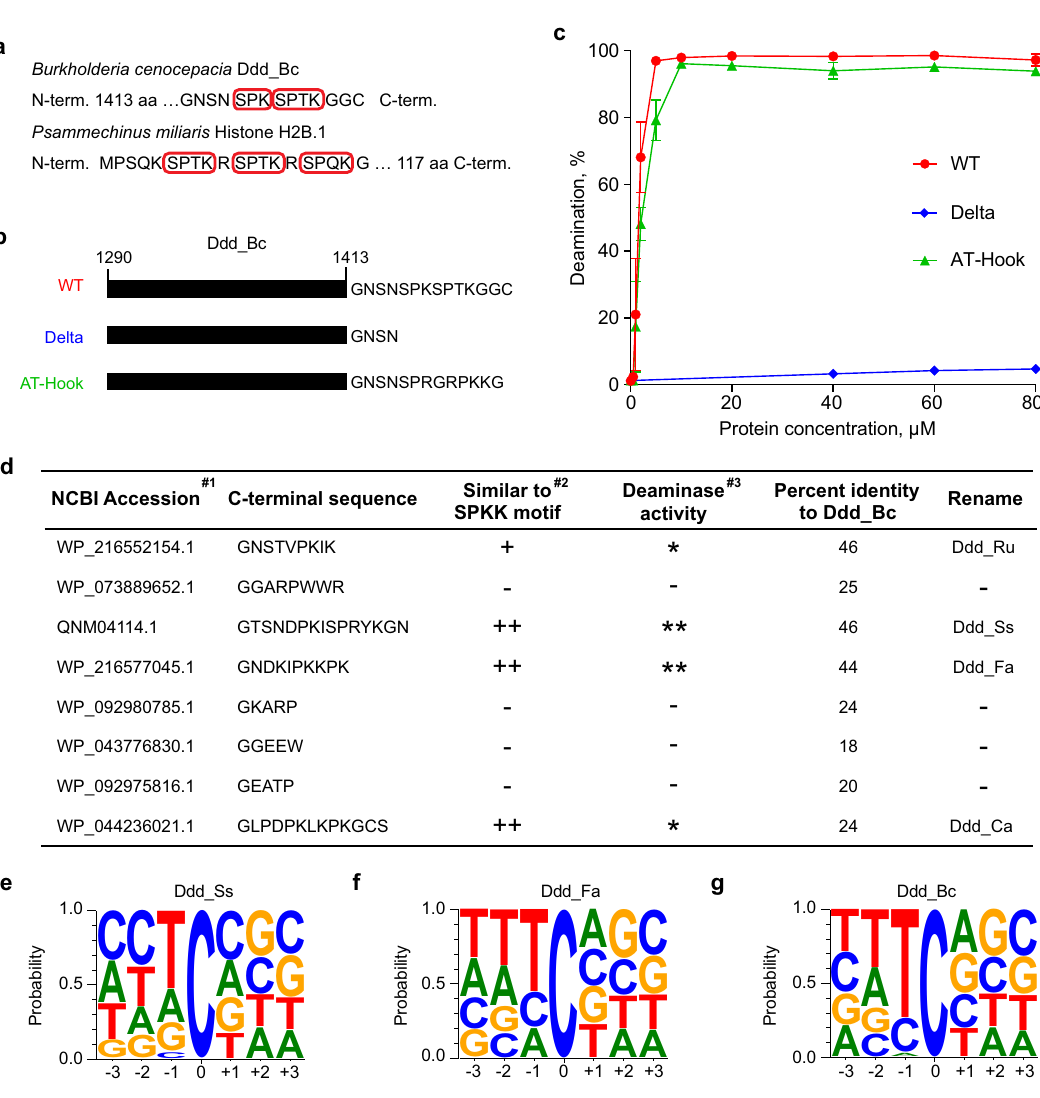
experiments. d Summary for the sequence features and the activity of candidate Ddd_Bc homologs. #1: Ordered by PSI-BLAST score, from high to low. #2: +, the C-terminal region has one SPKK-related motif; ++, two SPKK-related motifs; -, no SPKK-related motif. #3: *, activity comparable to Ddd_Bc; **, activity higher than Ddd_Bc;-,activityloworweak.Associatedgelsandquantifyingresultsareshownin Supplementary Fig. 2a – j. e – g Probability sequence logo of the region fl anking mutatedcytosinesfromthegenomeofUNG-de fi cient E.coli overexpressingDdd_Ss ( e ), Ddd_Fa ( f ), and Ddd_Bc ( g ). Source data are provided as a Source Data fi